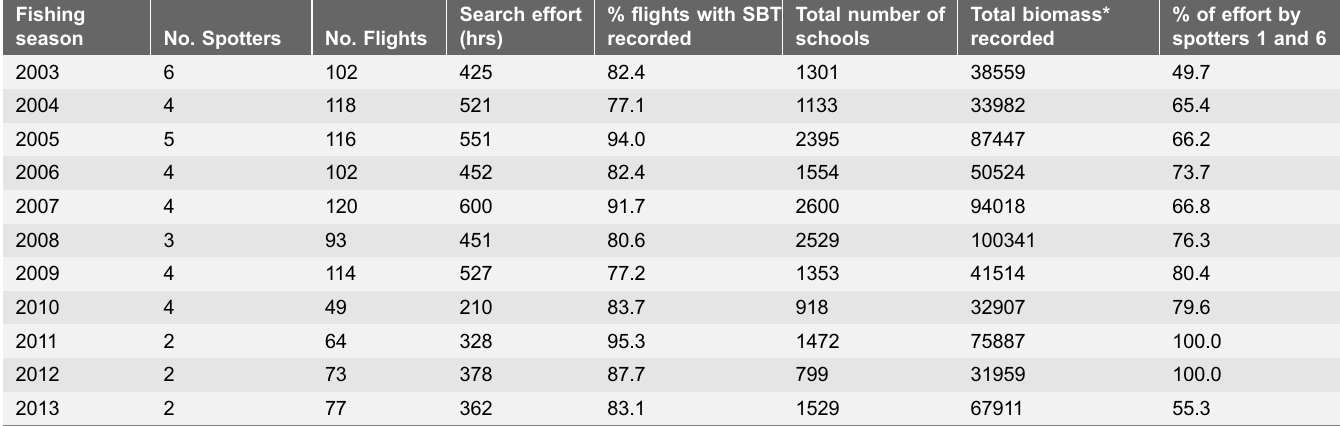
Table 1. Search effort and SBT sighted by commercial spotters in the 2002–2012 fishing seasons. No.